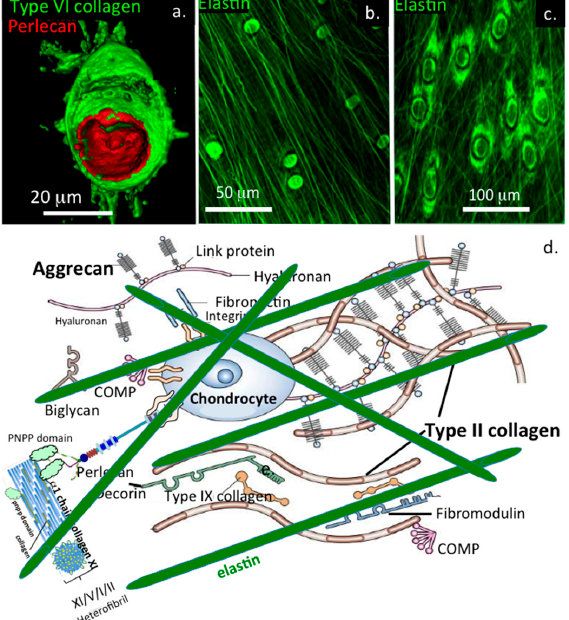
Figure 9. Elastin fibres are components of knee joint articular cartilage. ( a ) Scanning electron micrograph showing the fibrous structure of a chondron surrounding an articular cartilagechondrocyte ( b ) Surface rendered model of a chondron showing the 3D organisation of type VI collagen (green) and perlecan (red) based on confocal data published in [42] ( c , d ) Immunofluorescence localisation of elastin (green) within knee joint articular cartilage. Elastin occurs as discrete matrix fibres and as pericellular material focused around chondrocytes. ( e ) Diagrammatic representation of the structural components surrounding articular chondrocytes. Elastin fibres are shown in green. Images a, c, d reproduced from [125] through Open Access. Image e modified [126] under Open Access.